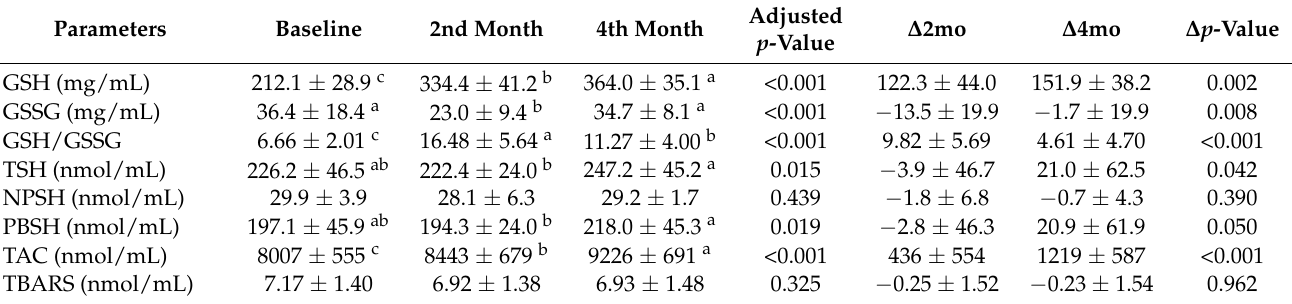
Table 3. Plasma concentrations of antioxidant indices and lipid peroxidation